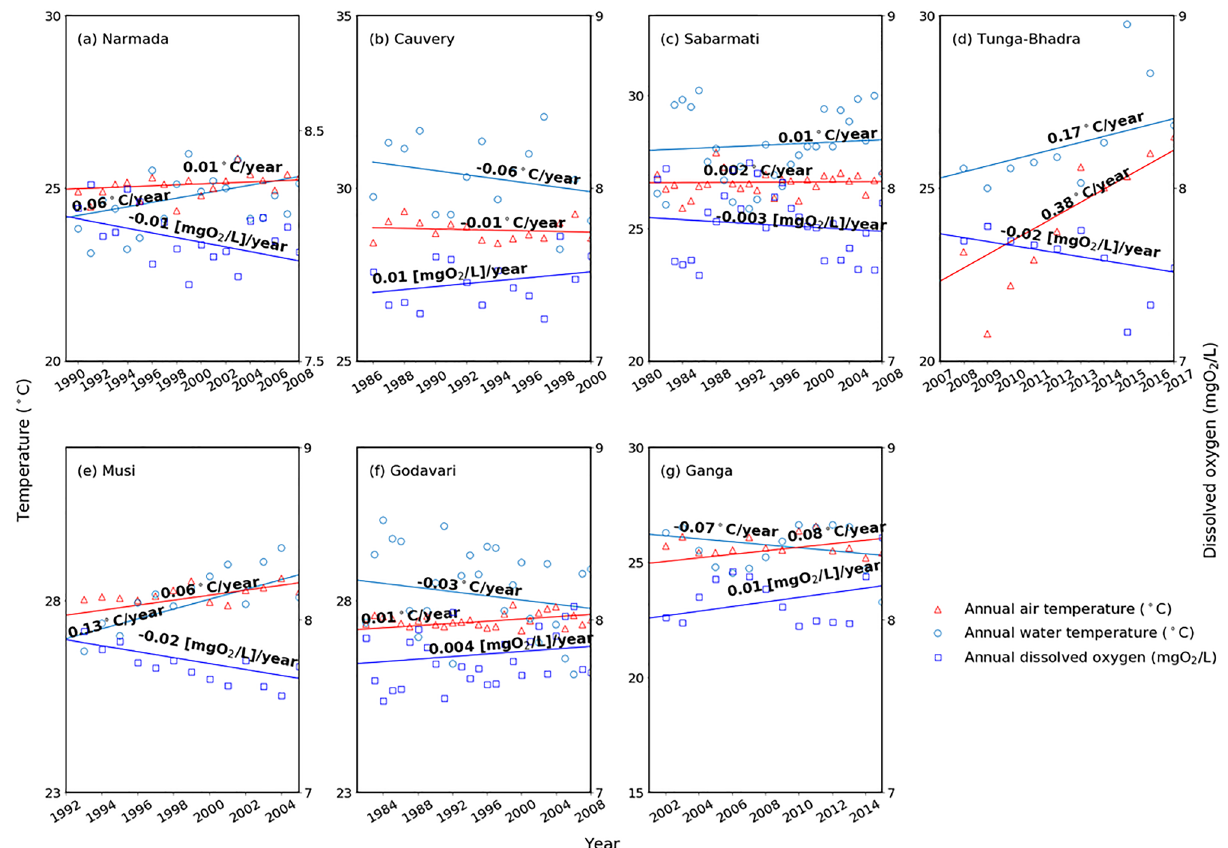
Tunga-Bhadra, ( e ) Musi, ( f ) Godavari and ( g ) Ganga. Linear regressions of the time series are represented by trend lines, and the slope parameters are trend